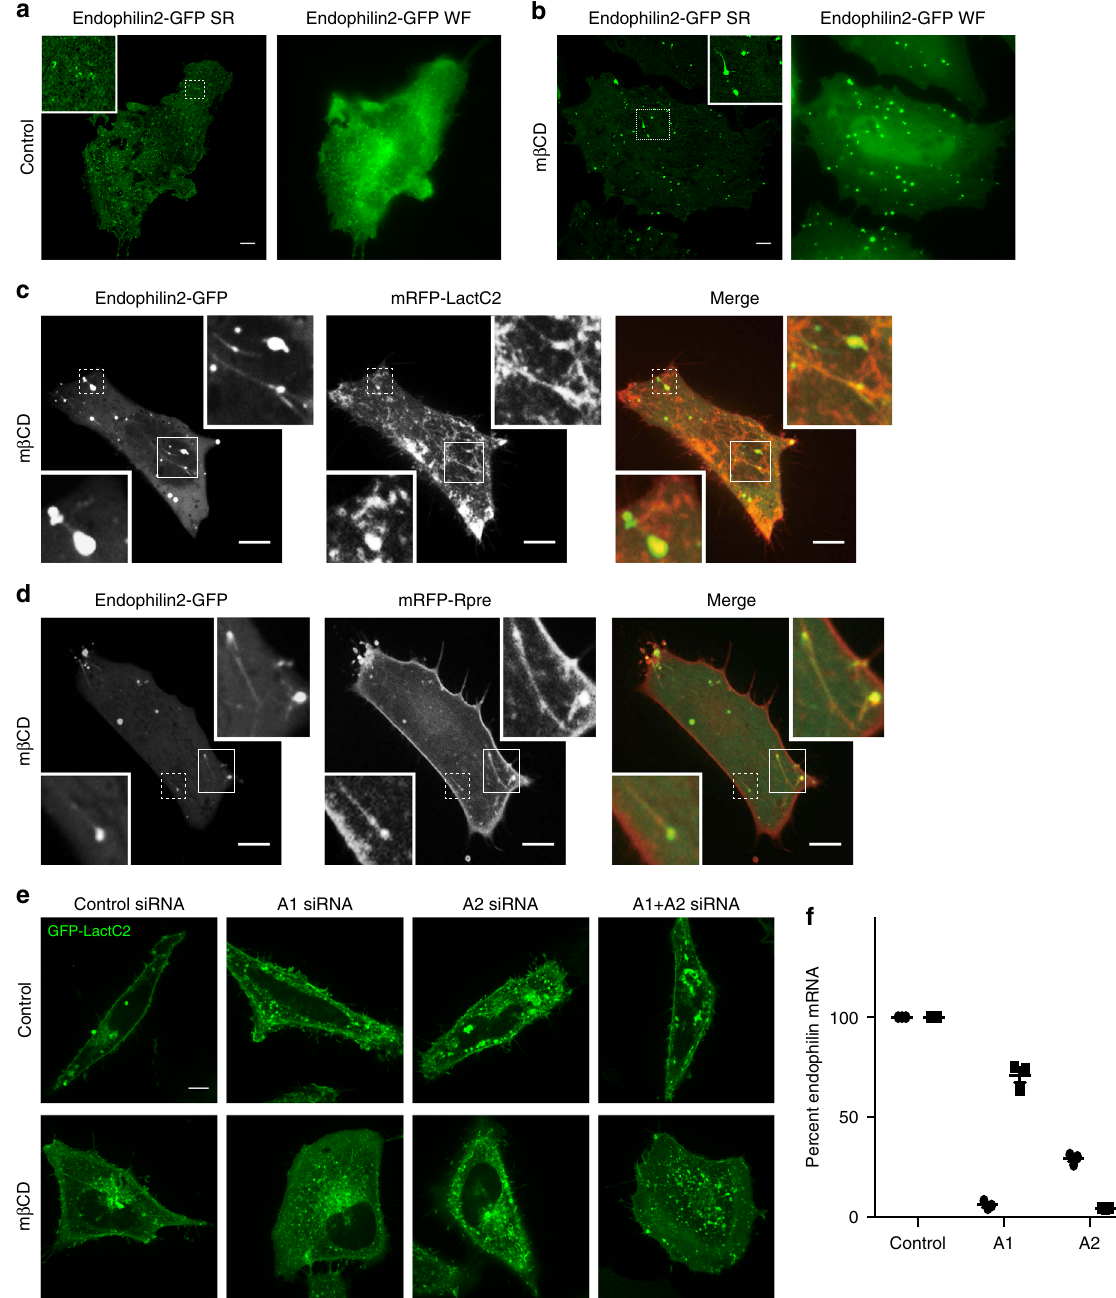
Fig. 7 Endophilin is recruited to sights of internalization but is not required. Control ( a ) and m β CD-treated ( b ) HeLa cells expressing endophilin2-GFP were images using wide- fi eld (WF) and super-resolution structured illumination microscopy (SR). c , d Confocal images of HeLa cells co-expressing Endophilin2- GFP and either mRFP-LactC2 or the charge probe mRFP-Rpre following the addition of m β CD for 2 min. Insets: magni fi cation of the areas indicated by a square. e HeLa cells were co-transfected with the indicated Stealth RNA (control, endophilin A1, endophilin A2, or both) and GFP-LactC2. Confocal images of control cells and cells 20 min following the addition of m β CD. f Quantitation of Endophilin A1 and A2 mRNA transfected following transfection with control and endophilin A1 and A2 Stealth RNA. Data represent the means ± s.e.m., n =